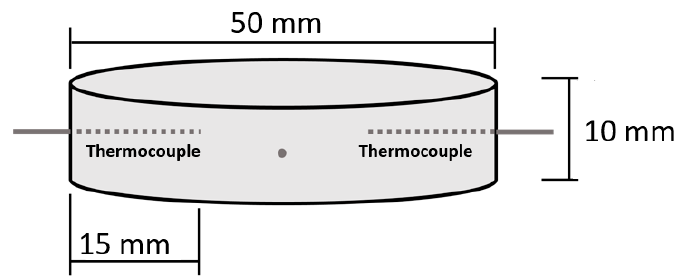
Figure 1. Sketch of metal disc with inserted thermocouples at 90° horizontal separation [5].